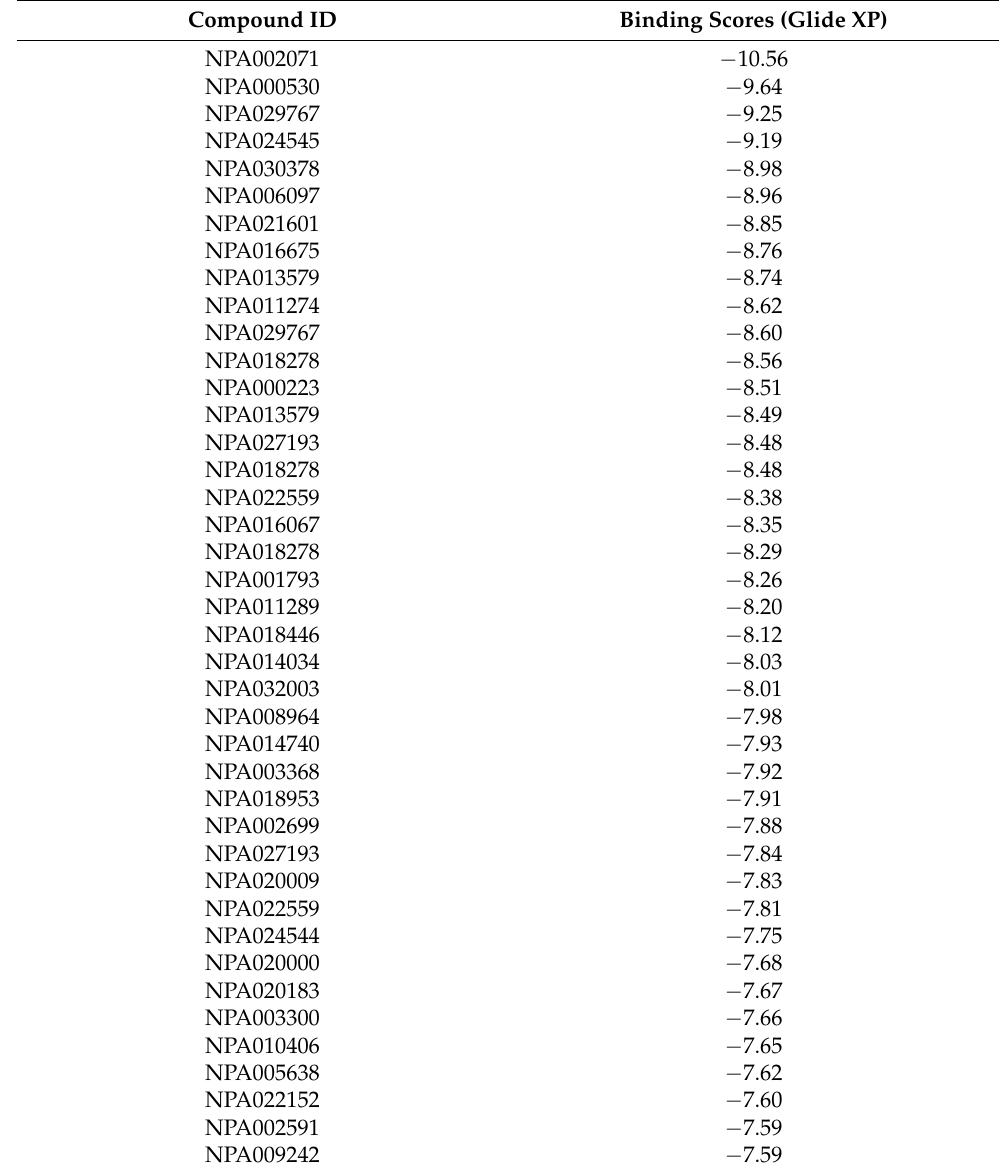
Table 1. List of top 41 NP_ATLAS database compounds screened against the binding pocket of the modeled 3D structure of MPXV